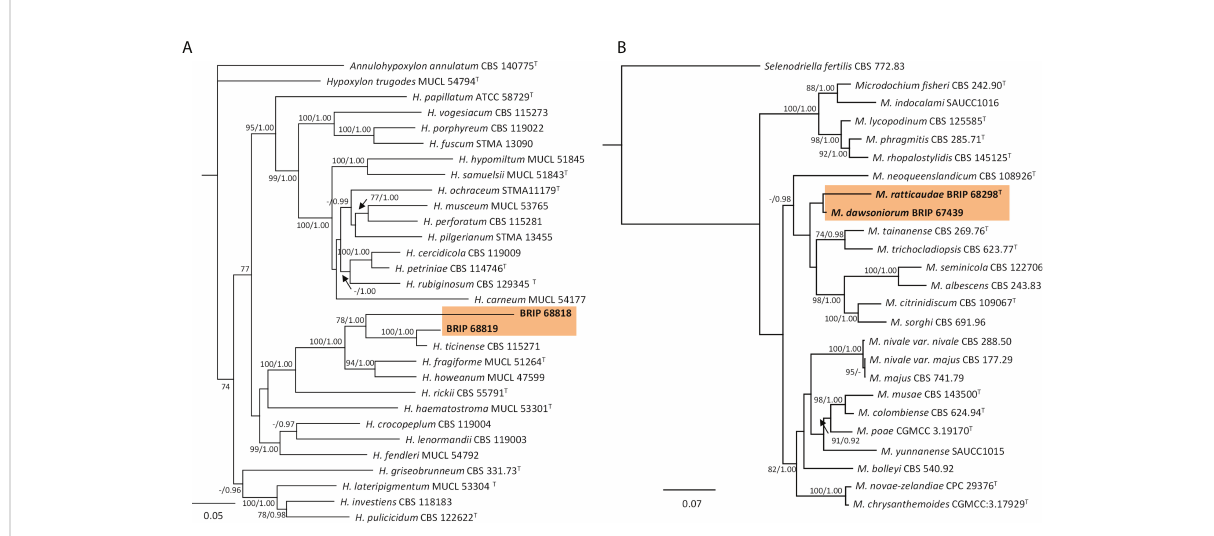
FIGURE 15 Phylogenetic trees inferred from RAxML analyses of strains in Xylariales based on concatenated alignments of (A) ITS, LSU, rpb2 and tef1- a sequences of related species in Hypoxylaceae; and (B) ITS, LSU and rpb2 sequences of related species in Microdochiaceae. RAxML bootstrap (bs) values greater than 70% and Bayesian posterior probabilities (pp) greater than 0.8 are given at the nodes (bs/pp). In bold font are the isolates from this study, and ex-type strains are indicated with T